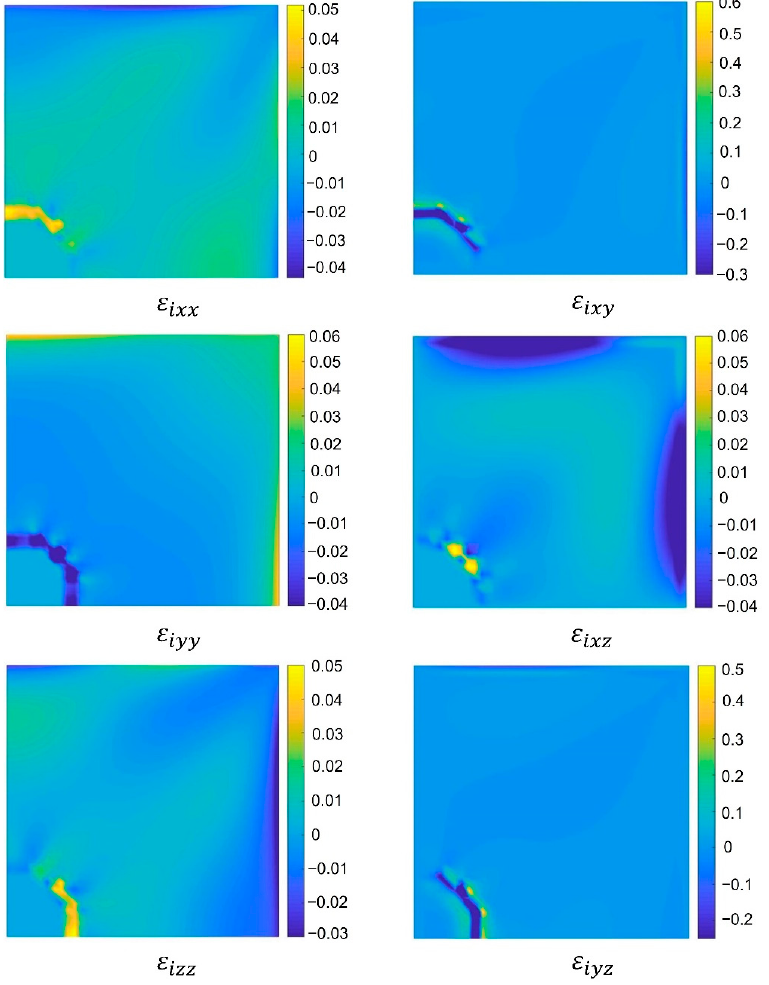
Figure 6. Monodomain normal and shear strains of intracellular space in the isotropic tissue. Each panel represents the XZ plane of the tissue at Y = 1. The fibers are horizontal.